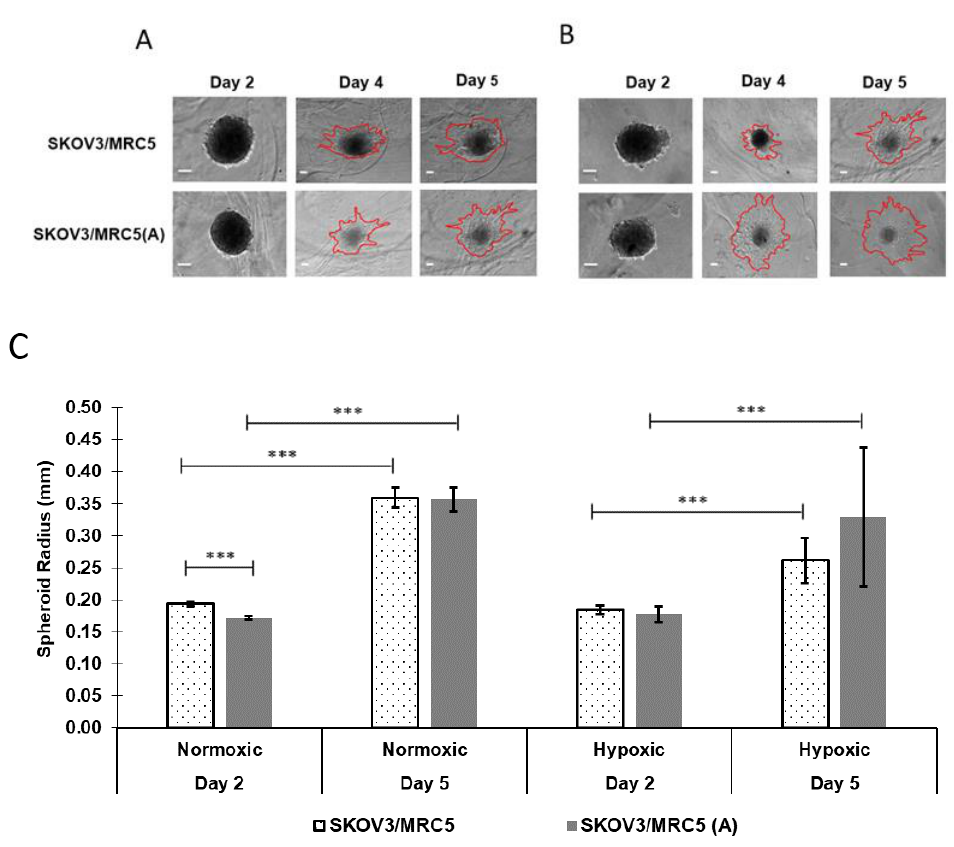
Figure 3. Invasion of spheroids in PMX as a function of activation and oxygenation over 5 days measured as maximum cross-sectional spheroid radii. Representative phase-contrast images of ( A ) normoxic and ( B ) hypoxic PMX nonactivated (SKOV-3/MRC-5) and activated (SKOV-3/MRC-5(A)) spheroid growth. ( C ) Spheroids increased in size in both normoxia and hypoxia, with no difference between the activated and nonactivated stromal conditions by 5 days. Data were deemed statistically significant using one-way ANOVA (*** p ≤ 0.0005). Error bars represent the mean ± standard deviation. Scale bars represent 100 µ